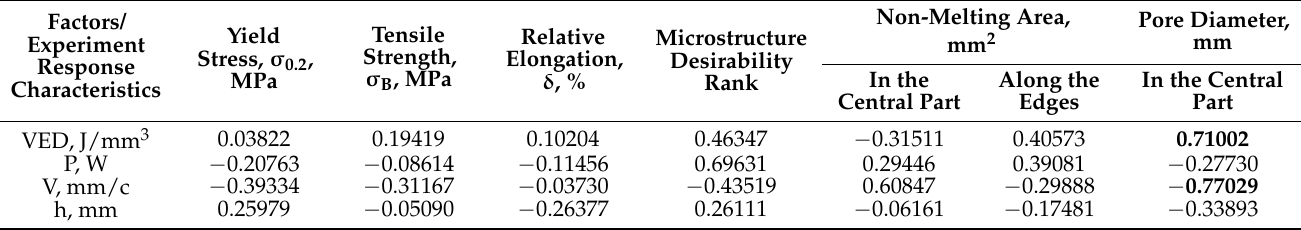
Table 6. Parameter correlation matrix.